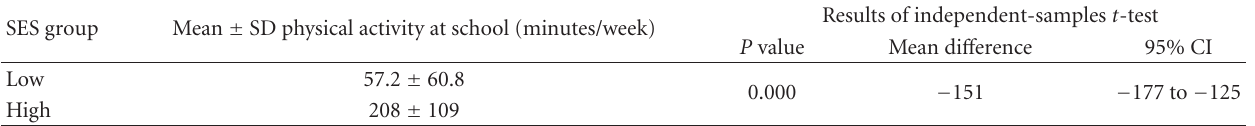
Table 6: Time spent in physical activities at school by low and high socioeconomic